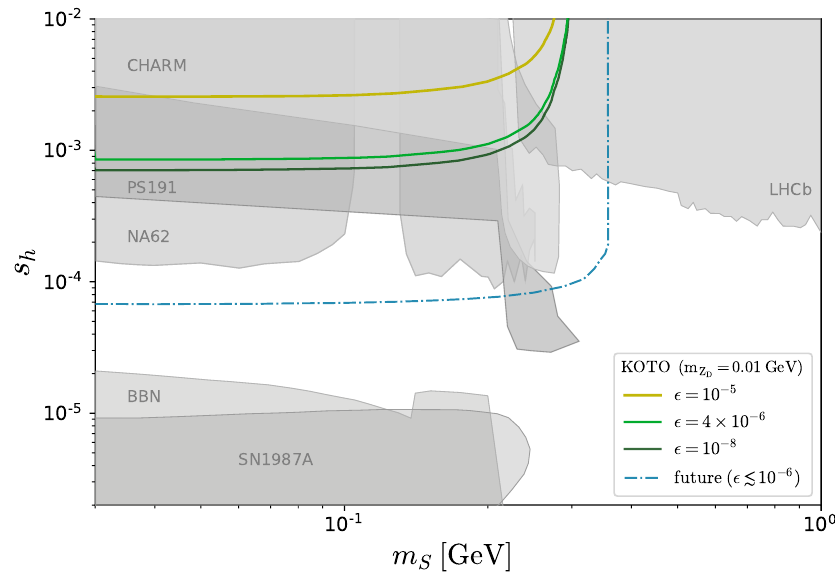
Figure 4 . Current bound on the HAHM dark Higgs parameter space considering KOTO upper limit BR( K L → π 0 X ) [31] and fixing m Z = 0 . 01 GeV. The different solid curves consider (cid:15) = 10 − 5 D (yellow), 4 × 10 − 6 (green) and 10 − 8 (dark green). We show in blue dashed-dotted the maximum future sensitivity of the KOTO experiment assuming the SM prediction for BR( K L → π 0 ν ¯ ν ) can be attained. The gray regions represent the limits from the LHCb collider experiment ( B →